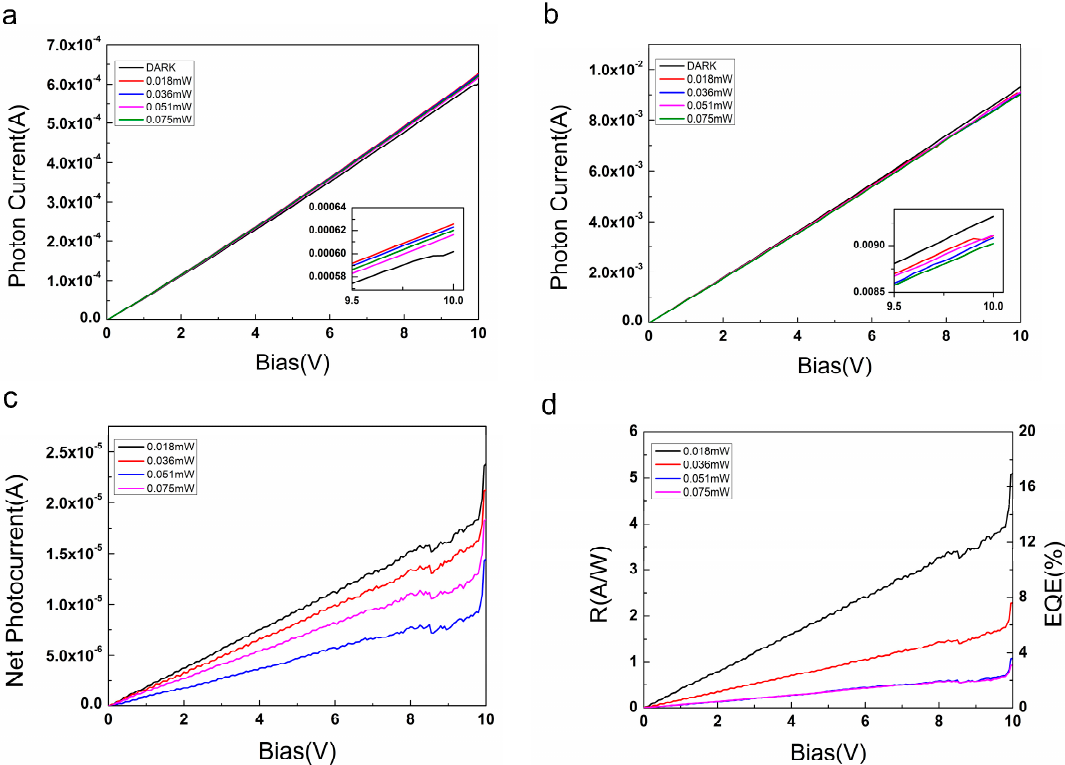
Figure 5. ( a ) Photon currents of QFSG samples, obtained with and without illumination, the excited wavelength is 650nm and the laser power is provided in the figures. The details of the data are magnified and displayed in the inset. ( b ) Photon currents of EG samples, obtained with and without illumination. The details of the data are magnified and displayed in the inset. ( c ) Net photocurrents of QFSG sample, reported as a function of the bias voltage, for different values of the light power. ( d ) Responsivity and external quantum efficiency of QFSG sample, reported for different values of light power.